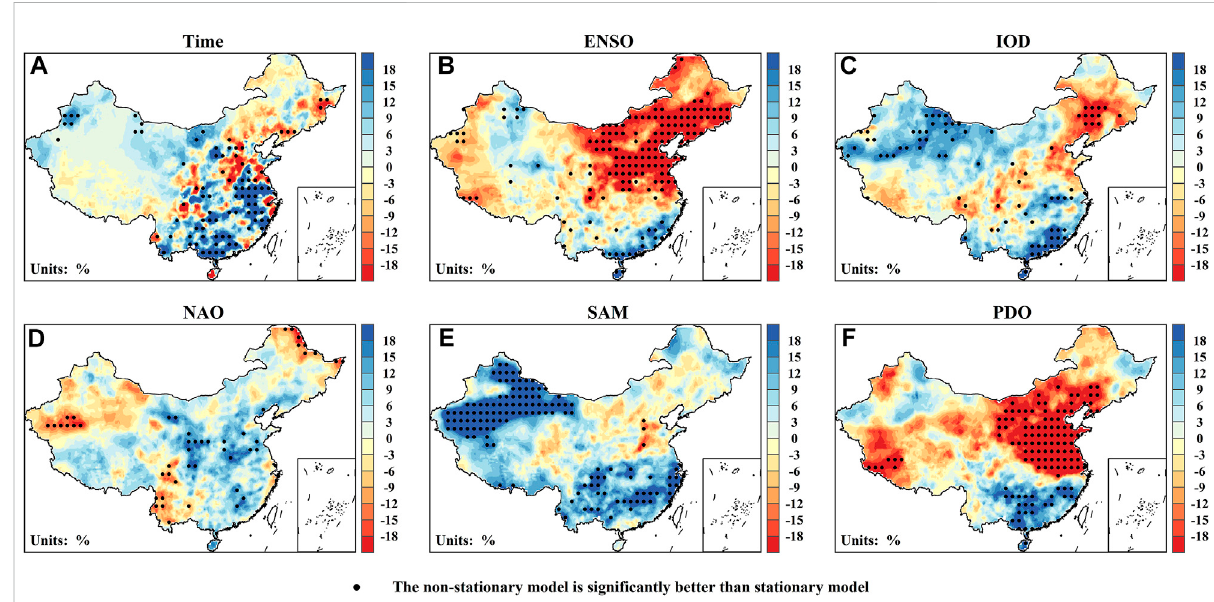
FIGURE 5 Change in the occurrence probability of 20-year extreme precipitation estimated by the non-stationary GEV distribution. The six covariates in the non-stationary GEV distribution are time (A) , ENSO (B) , IOD (C) , NAO (D) , SAM (E) and PDO (F) . For example, the ENSO is taken as the covariate, andthechangeisthedifferenceinoccurrenceprobabilityestimatedfromthemaximumandminimum fi veENSOvalues.Theblue/redareasindicate the occurrence probability of 20-year extreme precipitation is higher/lower during extreme ENSO positive than negative phase. Black dots indicate that the non-stationary model has better performance than the stationary model at 0.05 signi fi cance level.